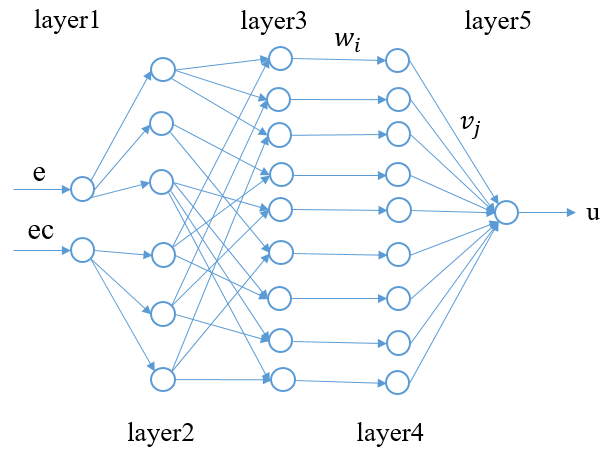
Figure 3. Fuzzy neural network controller structure. The FNN was composed of five layers neurons: Layer 1 was the input layer, mainly including the position/attitude (velocity) error and the error rate. Input = [ e , ec